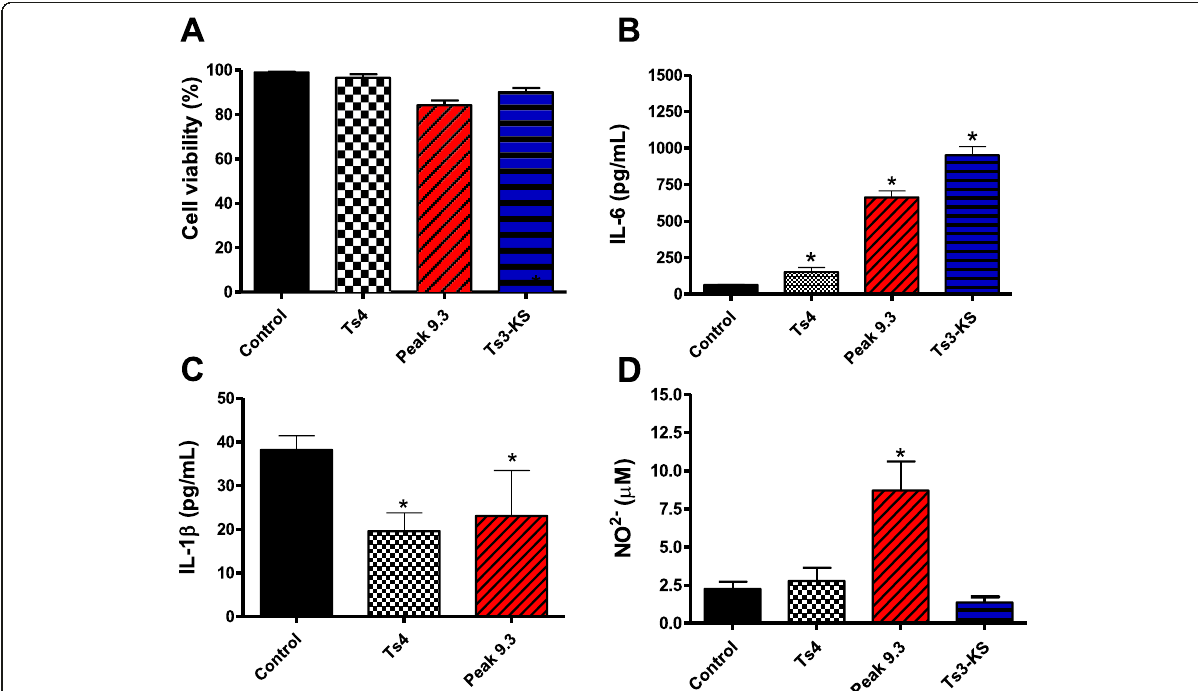
Fig. 4 Effects of Ts4, Ts3-KS and peak 9.3 # on macrophage viability and the cytokine and NO production. Adherent cells were stimulated with Ts4, Ts3-KS and peak 9.3 (50 μ g/mL) for 24 h in 5 % CO 2 at 37 °C. The supernatants were collected after 24 h. ( a ) Cell viability was measured by MTT assay. Each column represents the mean±SEM ( n =6), and the data are from two independent set of experiments (* p <0.05 compared to control, non-stimulated cells). The concentrations of the cytokines ( b ) IL-6 and ( c ) IL-1 β in the supernatants were determined by ELISA. The amount of ( d ) NO 2 − present in the supernatant was determined by the Griess method. Values are expressed as mean±SD ( n =4). * p <0.05 compared to control, non-stimulated cells (ANOVA and Dunnett's post-test). # Peak 9.3: Ts19 Frag-I contaminated with Ts2 and